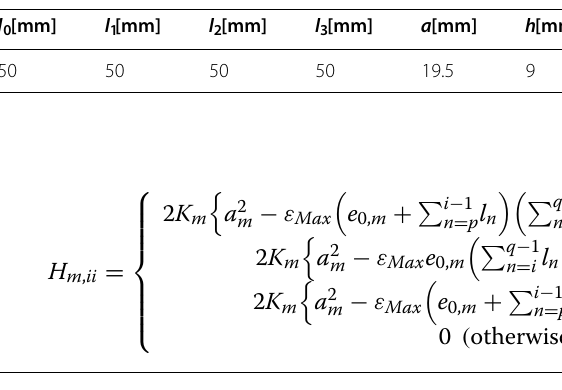
Table 1 Parameters of multi-serial-link mechanism